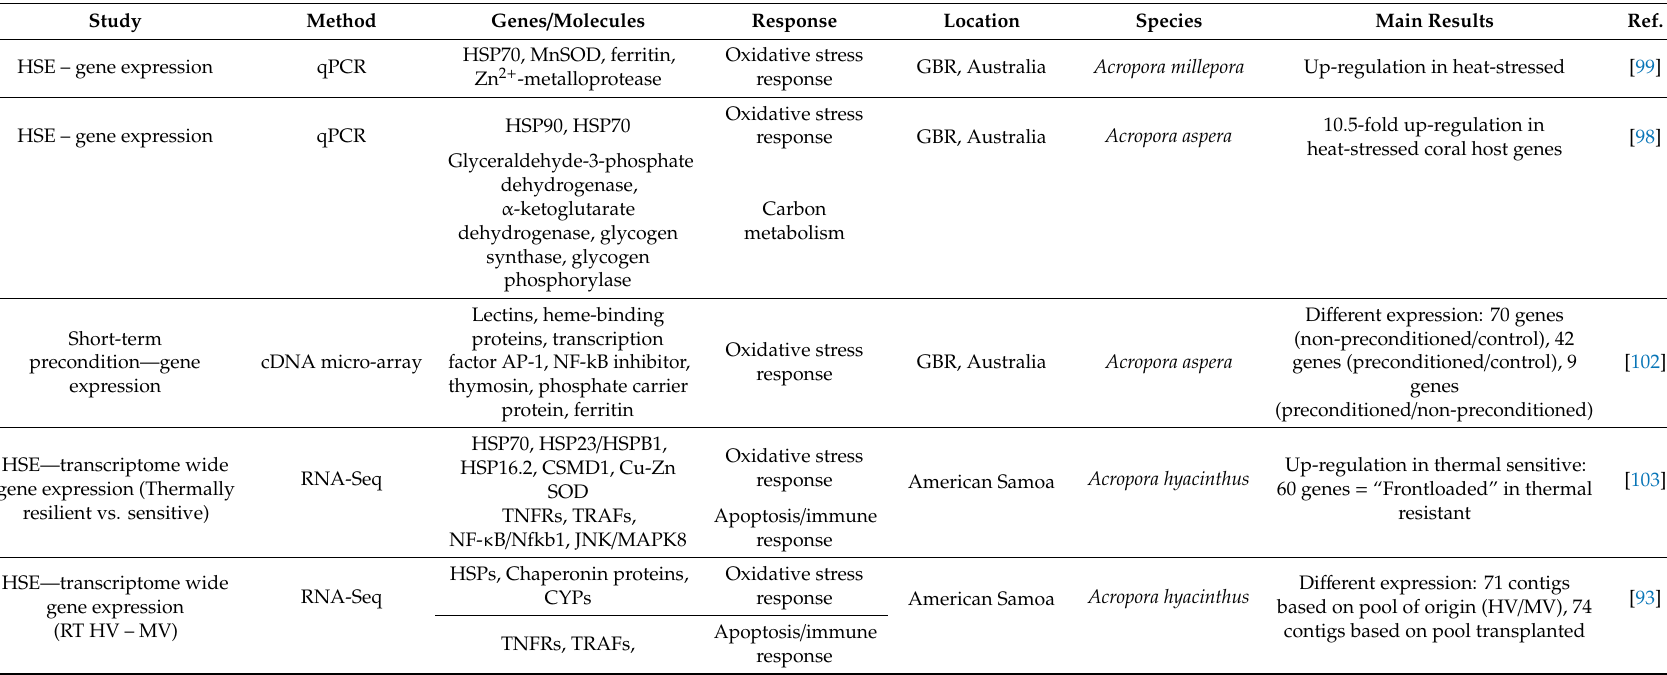
Table 2. Thermal stress studies looking at di ff erences in gene